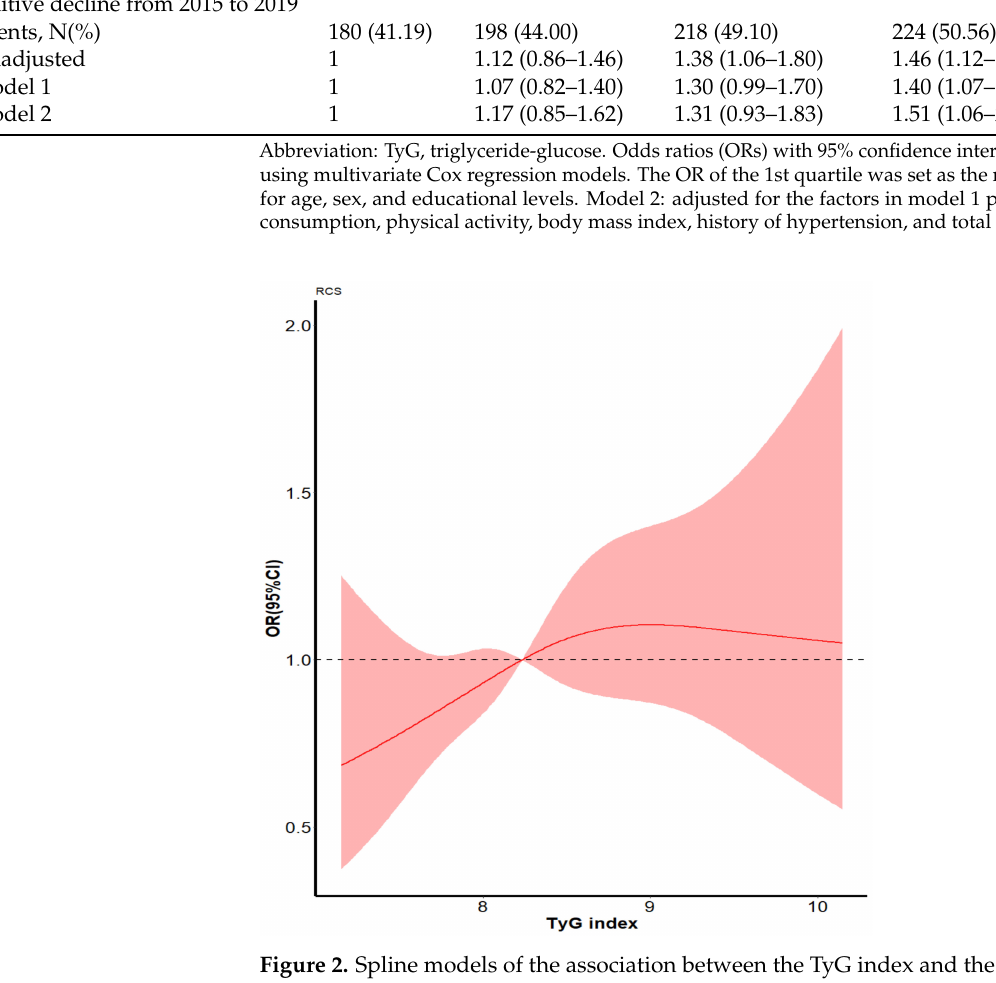
Figure 2. Spline models of the association between the TyG index and the risk of cognitive decline. The odds ratios from the multivariate Cox proportional hazard regression model were adjusted for the variables in model 2 in Table 3. The red line indicates the adjusted odds ratio, and the red area indicates the 95% confidence interval. Abbreviations: TyG,